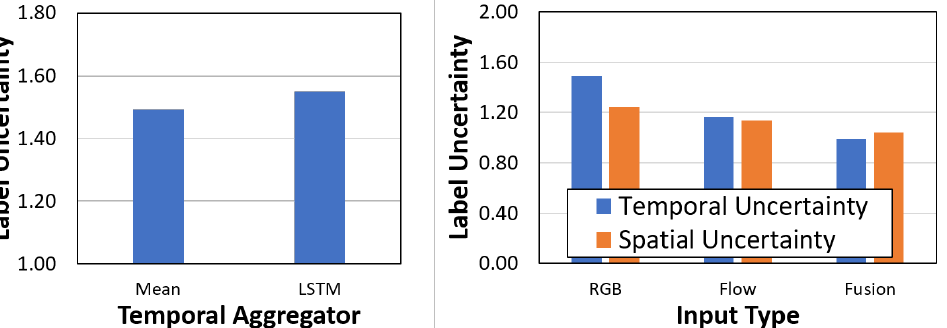
Figure 17. Left: Mean vs. LSTM aggregator. Right: Comparison with different input types. Evalu- ated on the MOVE dataset.